Question: According to the figure, is the described quantity increasing or decreasing?
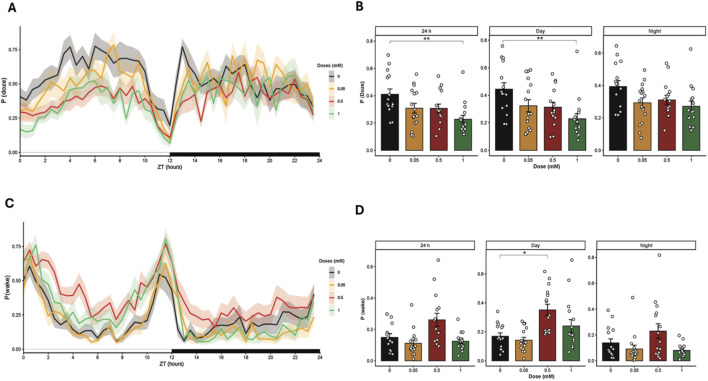
Answer: increasing